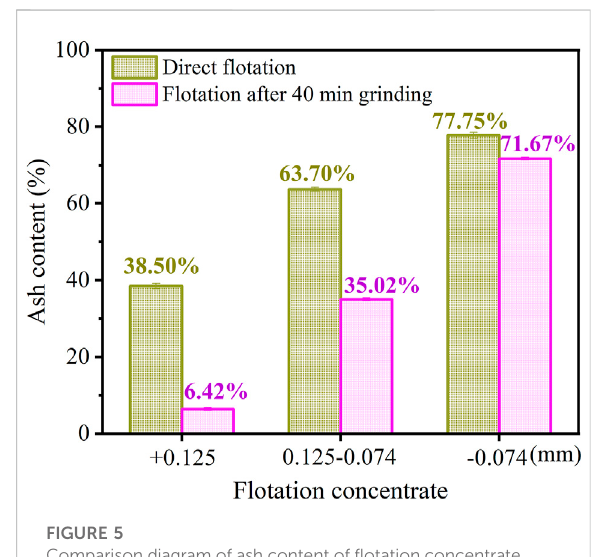
FIGURE 5 Comparison diagram of ash content of fl otation concentrate with different sizes under different